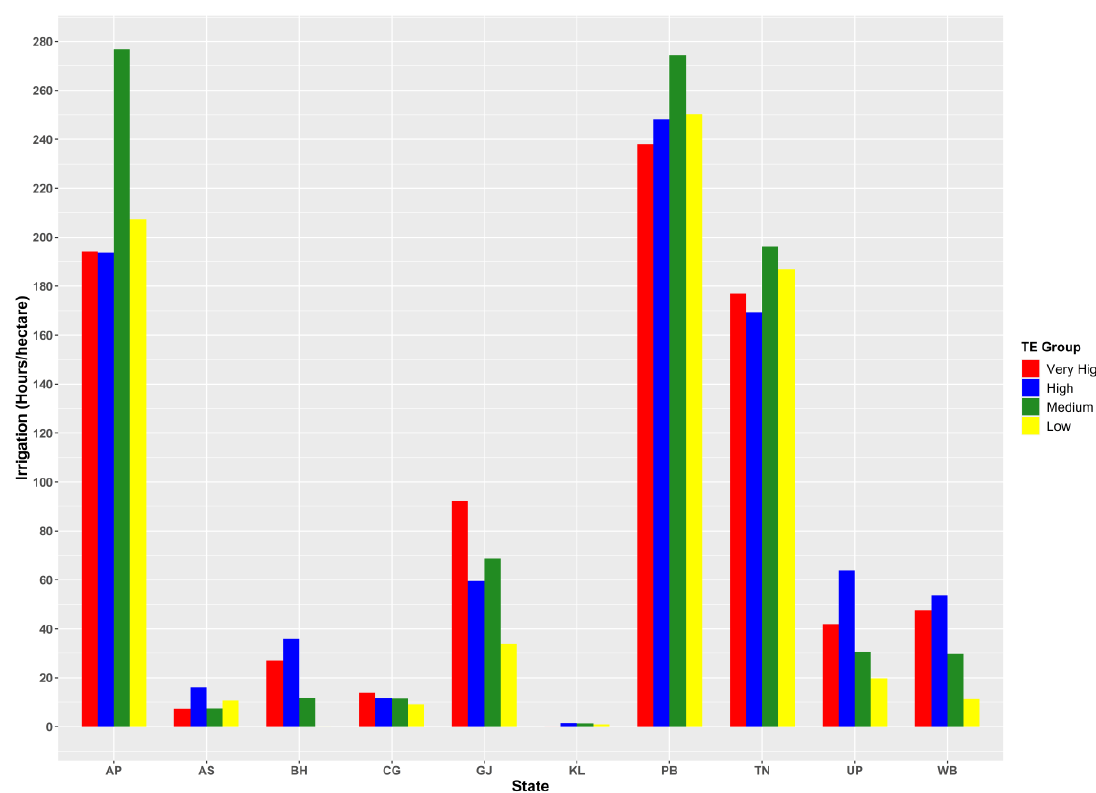
Figure 8. Irrigation in the paddy (hours/hectare) across various states and efficiency